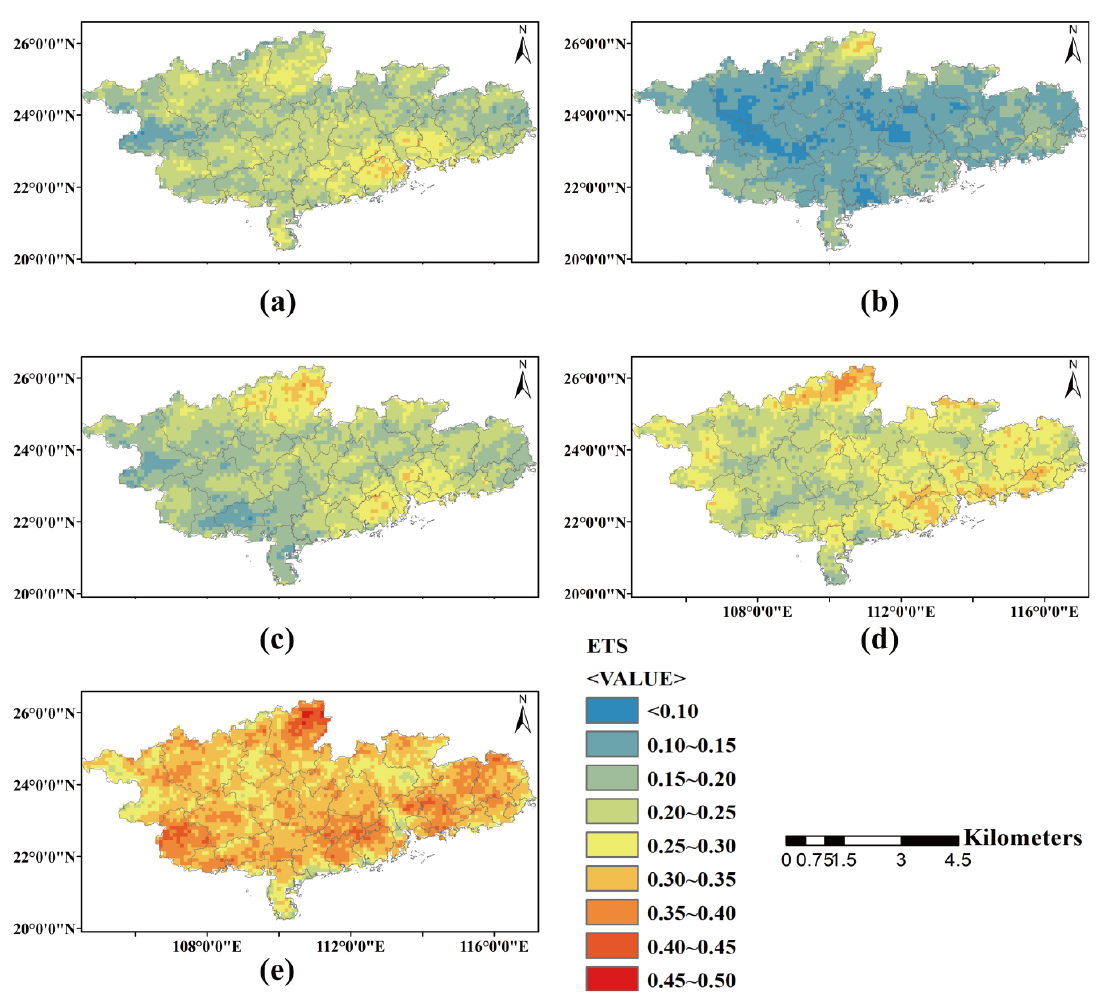
Figure 11. Spatial patterns in terms of equitable threat score (ETS) based on ( a ) PERSIANN-CCS, ( b ) ERA5-Land, ( c ) FY-4A, ( d ) GSMaP, and ( e ) IMERG against CMPA at hourly scale over southern China in summer 2019.